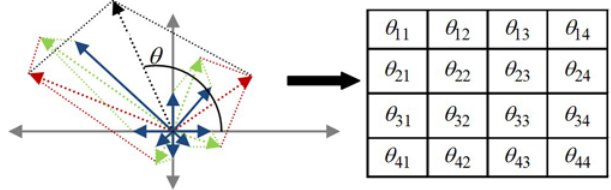
Fig 2. Angles computed from the sub-orientation